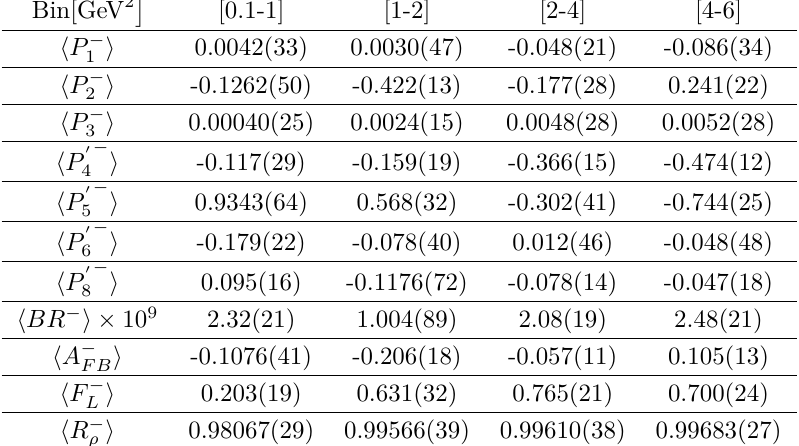
Table 8 . SM Predictions of observables for B − → ρ − ‘‘